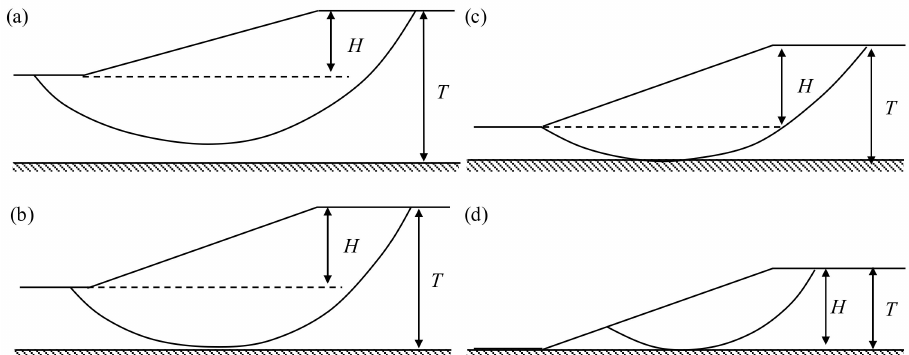
Figure 1. Di ff erent types of critical failure circles: ( a ) deep circle, ( b ) base circle, ( c ) toe circle, and ( d ) slope circle (modified from Gri ffi th and Yu